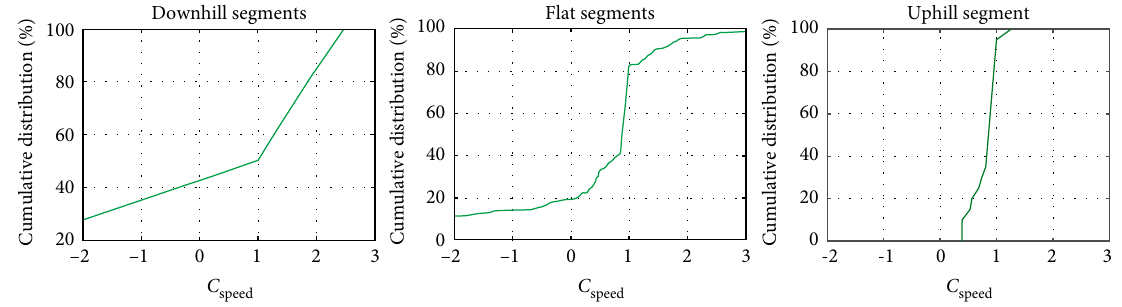
Figure 5: Speed compliance distributions for free and cruising segments in the field trials for drivers with desired speed above the speed limit.